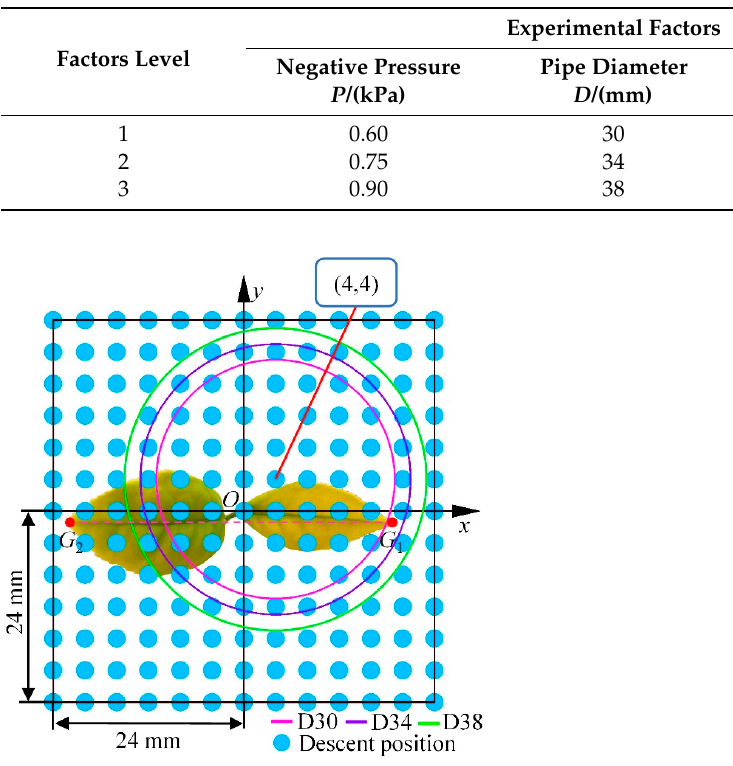
Table 2. Factor level of deviation tolerance orthogonal experiment.